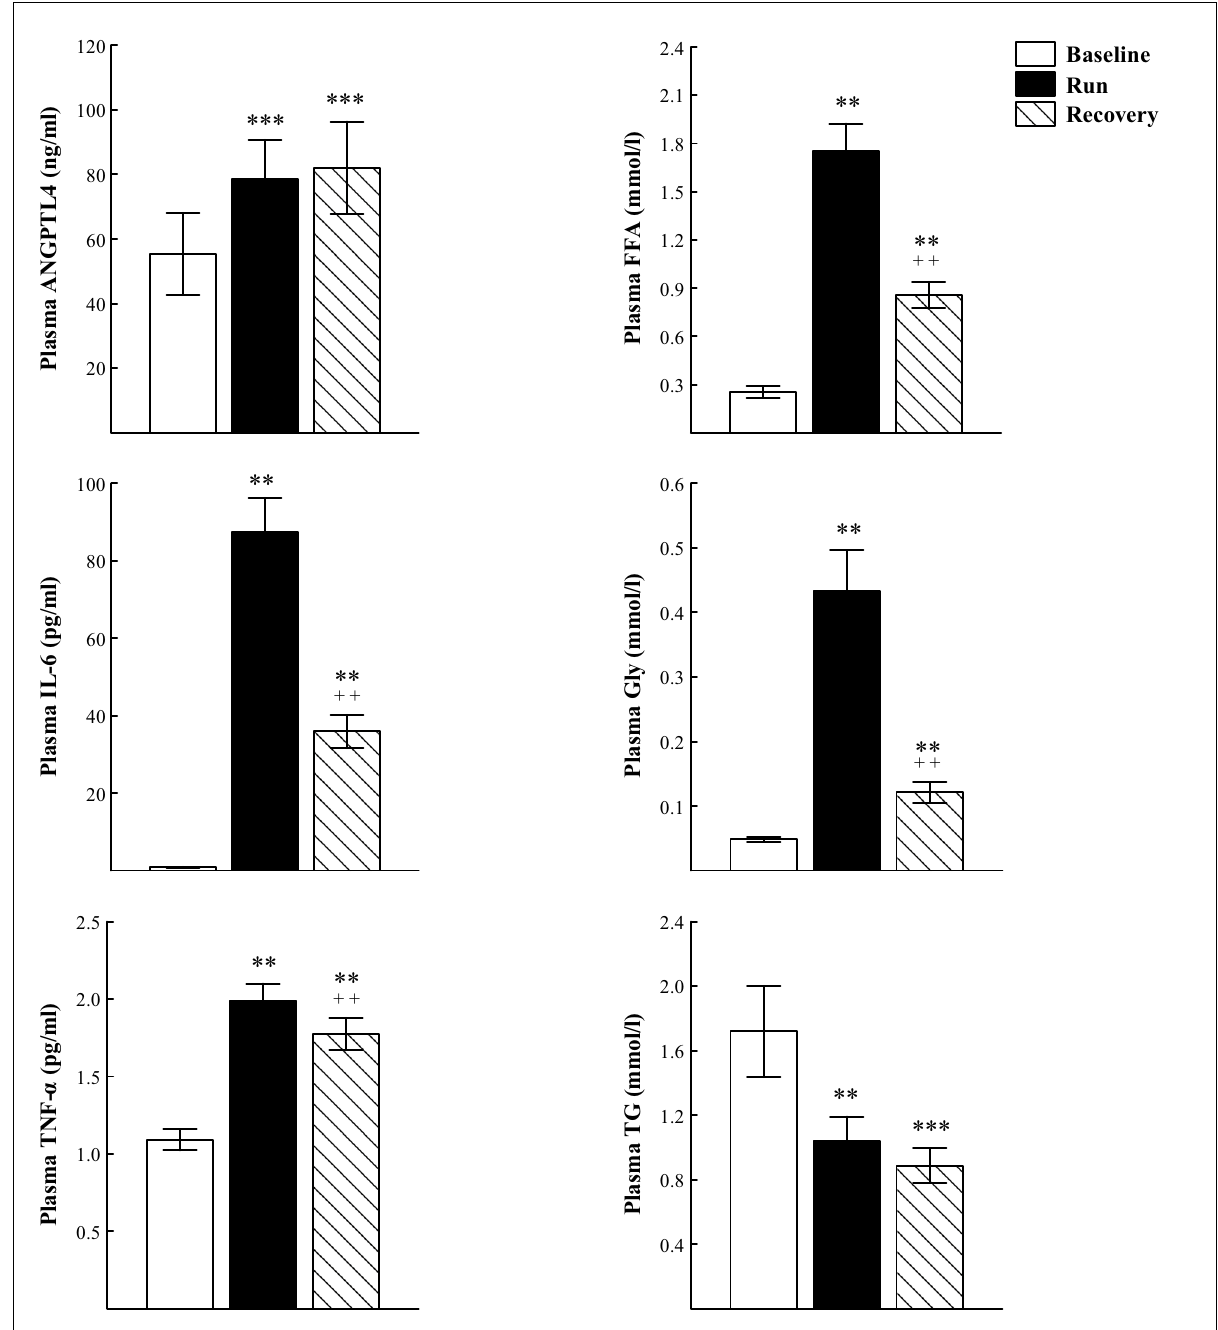
Figure 1. The plasma concentration of angiopoietin-like protein 4 (ANGPTL4), interleukin 6 (IL-6), tumor necrosis factor-α (TNF-α), free fatty acids (FFA), glycerol (Gly) and triacylglycerols (TG) before (Baseline), immediately after marathon run (Run) and at the 90 min of recovery (Recovery). The values are mean ± SEM ( n = 11). Asterisks denote significant differences from the resting values: **P < 0.01, ***P < 0.001. Crosses denote significant differences from the exercise values: ++ P <